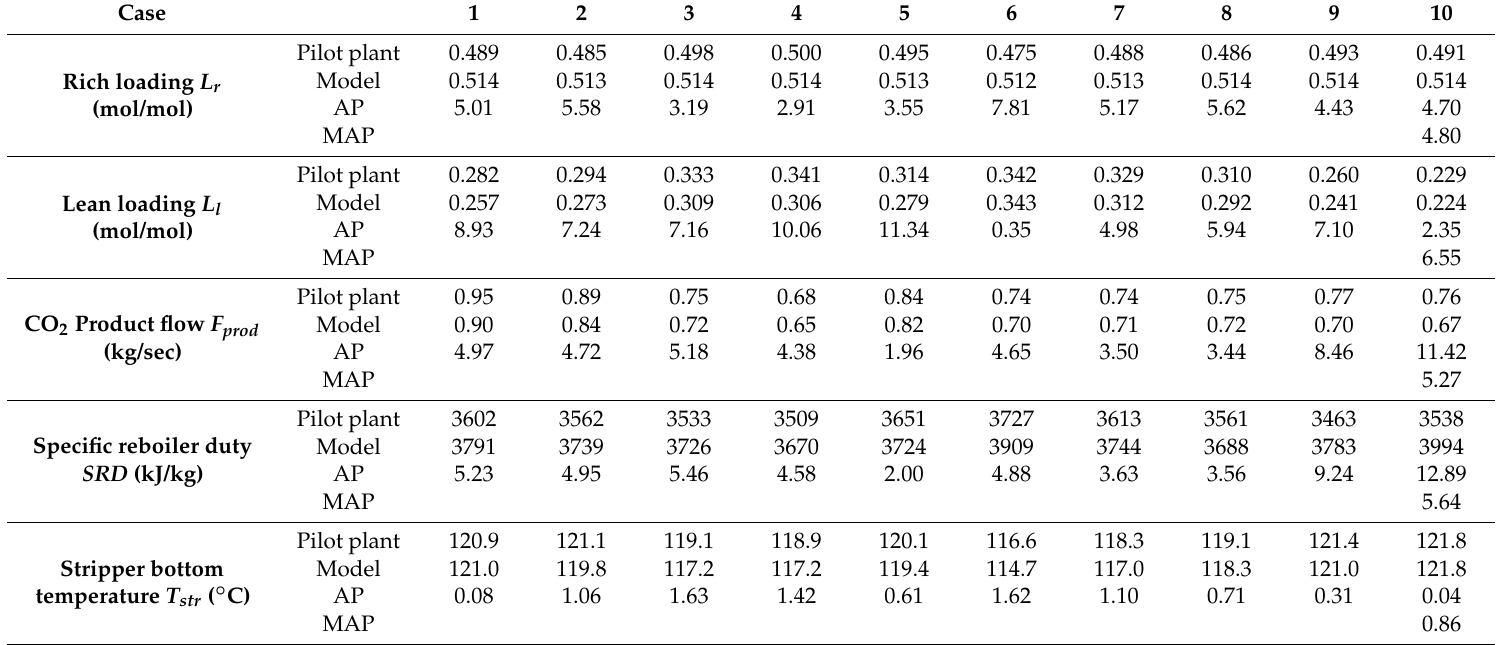
Table 4. Results from dynamic process simulation of the amine plant at TCM for the 10 steady-state operation cases. The pilot plant data for solvent CO 2 lean